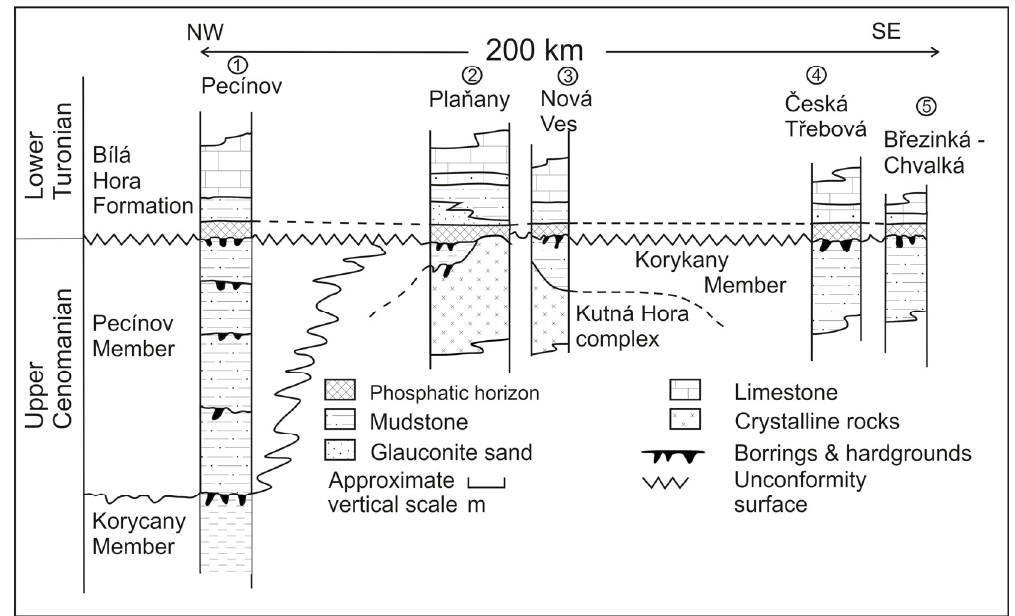
Figure 7. Stratigraphic correlation of the investigated Early Turonian phosphate occurrences of the Bohemian Cretaceous Basin (BCB) (See Figure 1 for geographic location).